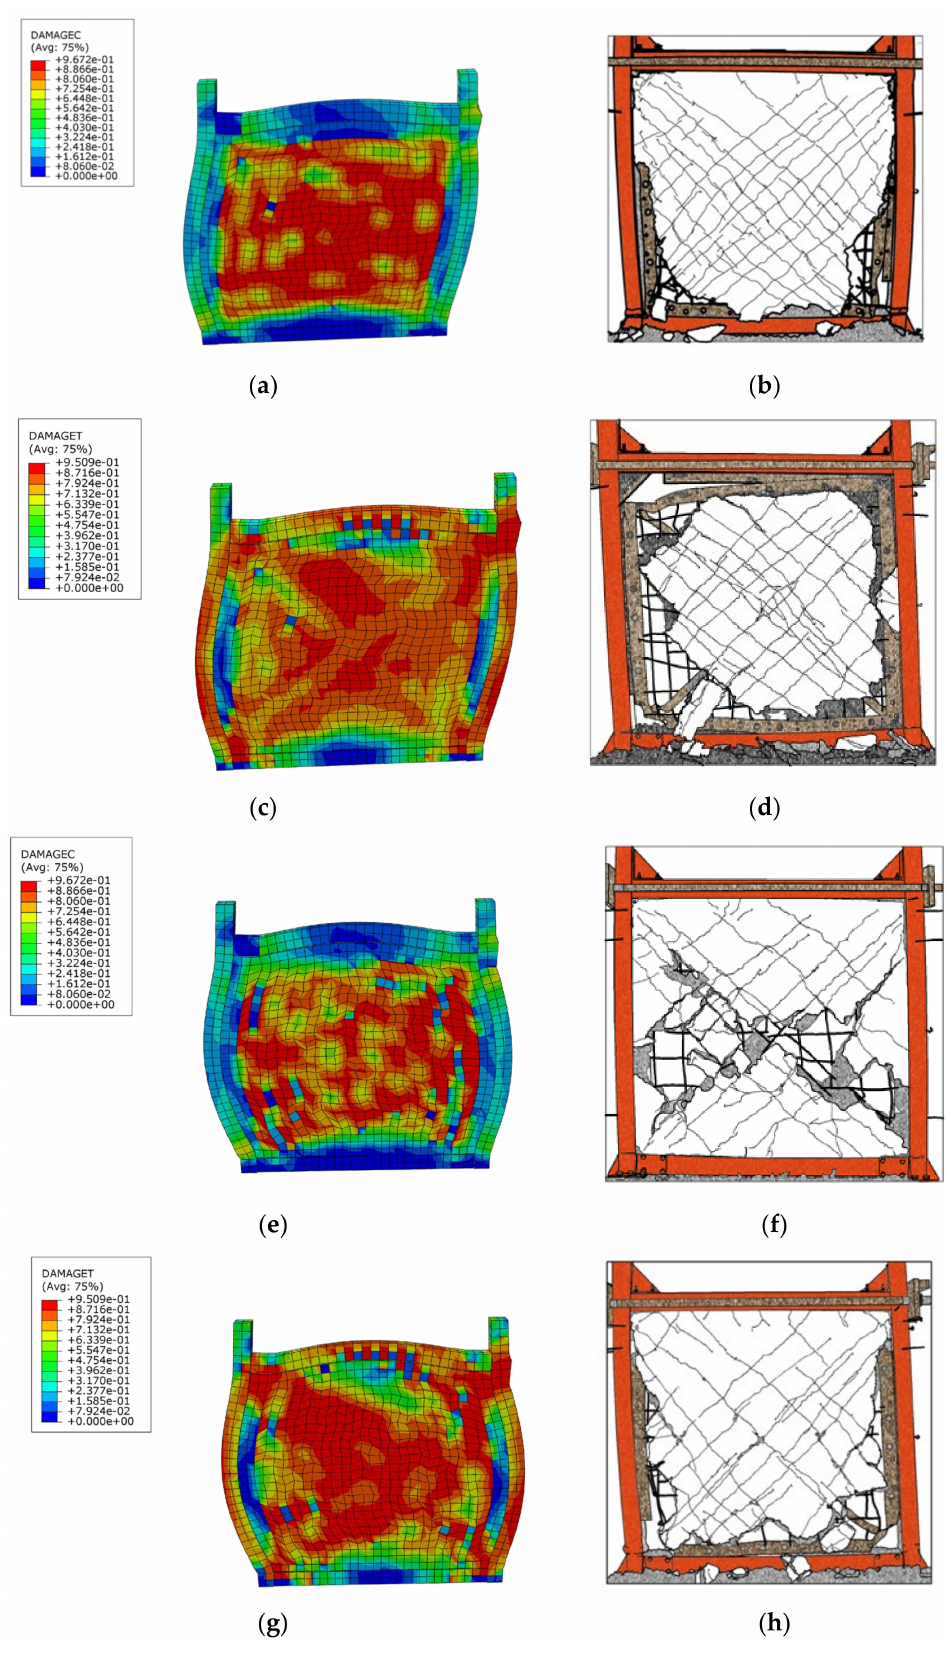
Figure 4. Failure morphologies of the virtual and actual test pieces. ( a ) Shear-stress contours of the wallboard of virtual test piece MX-1-1, ( b ) failure morphology of the actual test piece